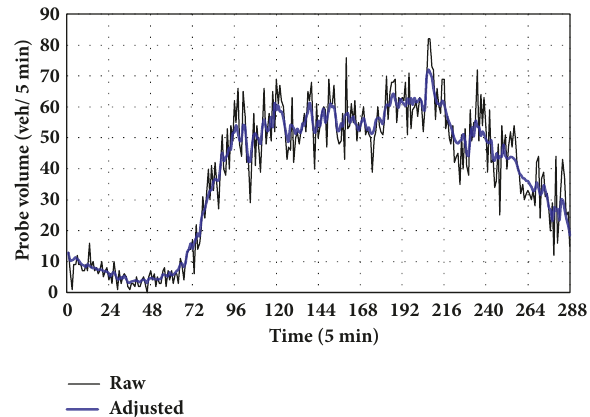
Figure 8: Temporal comparison of before and after